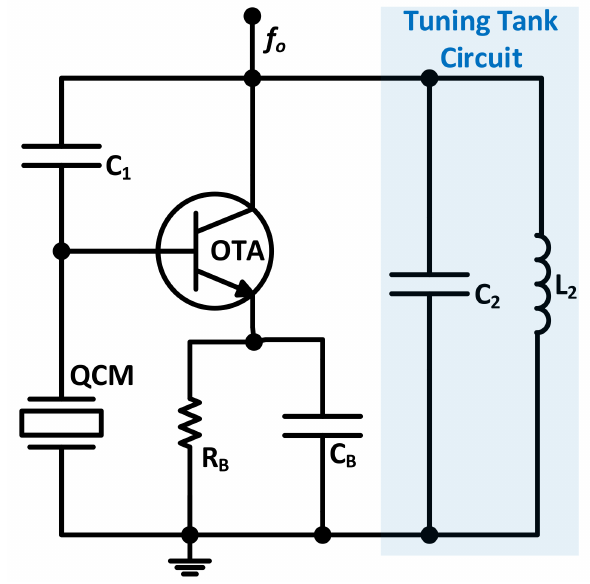
Figure 14. QCM based Miller oscillator implementation, from